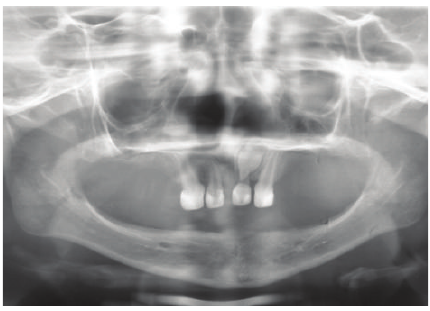
Figure 4: Panoramic radiograph showing oligodontia and lack of alveolar bone